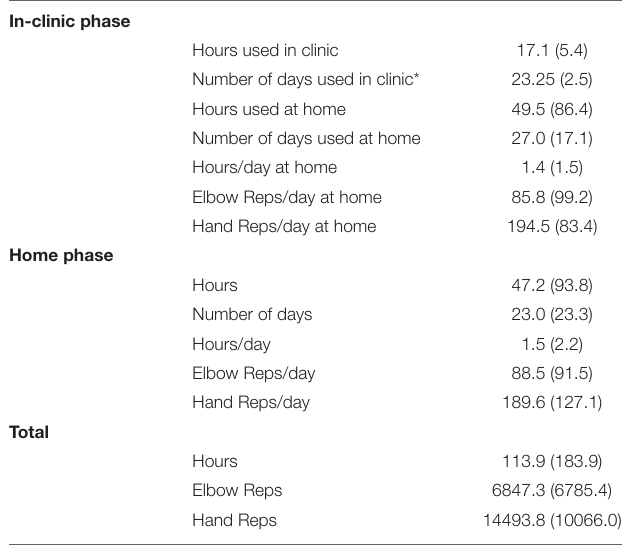
TABLE 4 | Orthosis utilization for the whole